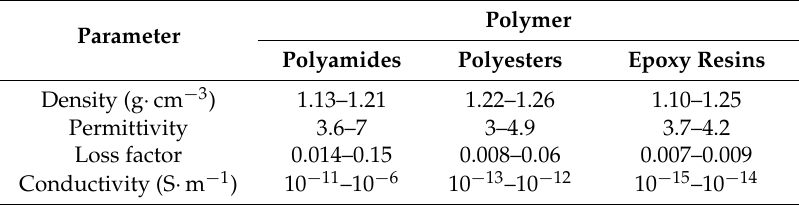
Table 1. Density (at 20 ˝ C), dielectric parameters (permittivity and loss factor, both at 20 ˝ C and 50 Hz), and conductivity (20 ˝ C, 50% r.h.) of polyamides, polyesters, and epoxy resins